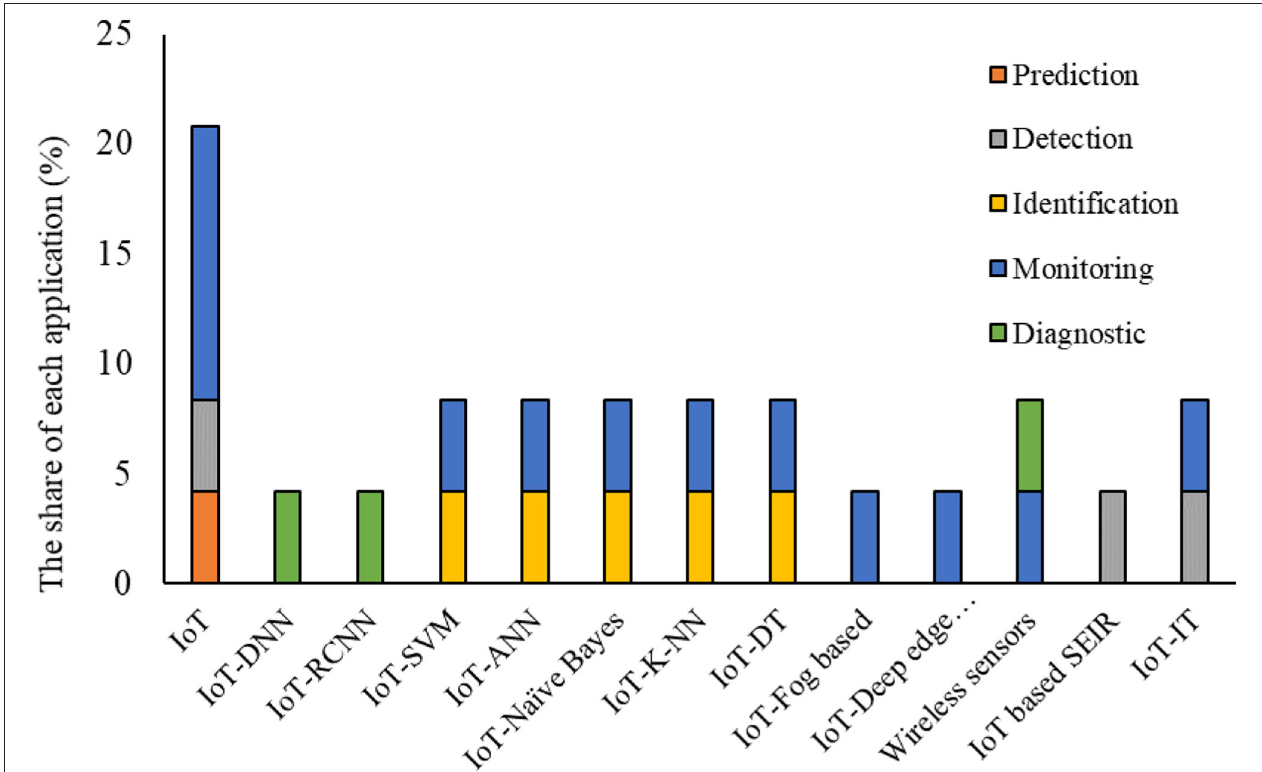
FIGURE 4 | The share of each application